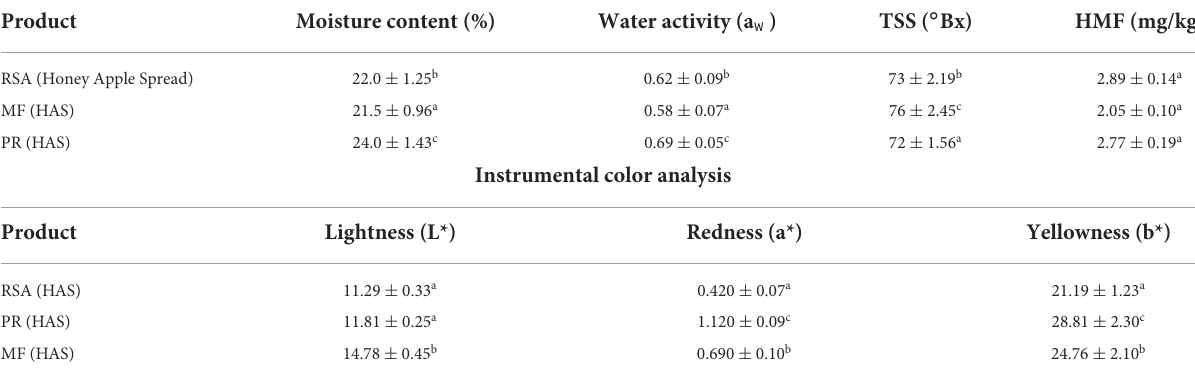
TABLE 2 Physico-chemical characteristics of honey based apple spreads.